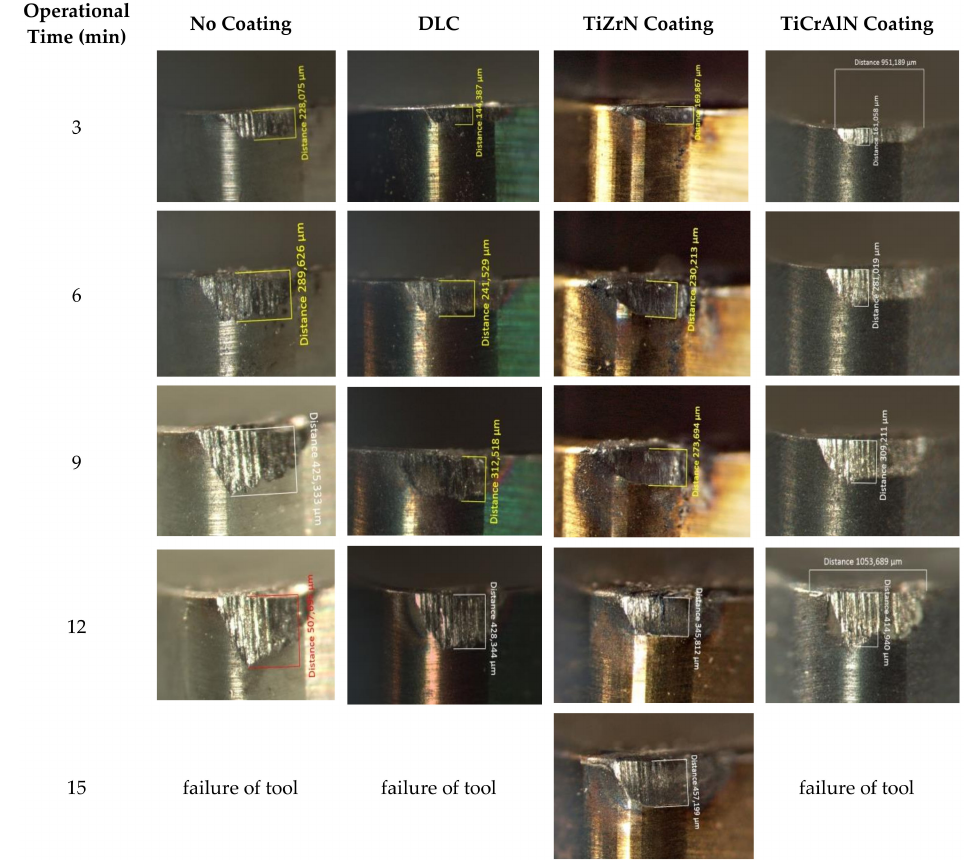
Figure 13. Kinetics of the wear of the cutting part of the Al 2 O 3 + SiC ceramic inserts with various coatings during the milling of hardened steel 102Cr6 with the following cutting conditions: cutting speed ( V ) = 380 m/min, feed ( S ) = 0.1 mm/tooth, and depth ( t ) = 1